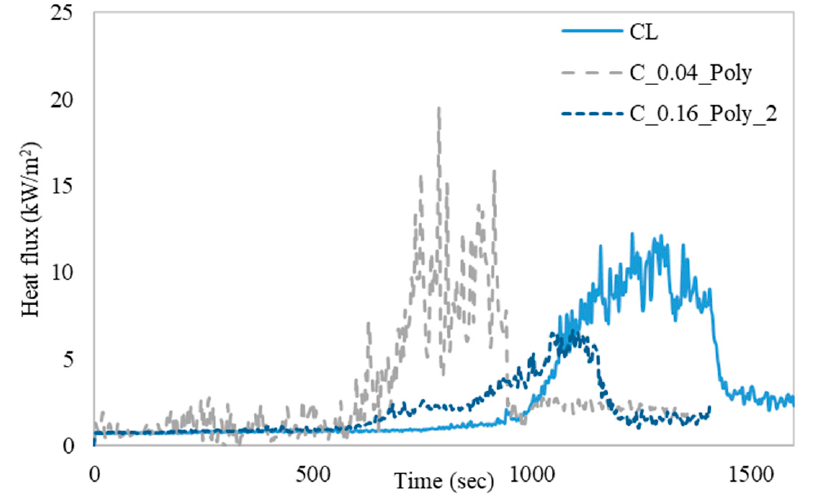
Figure 12. Heat flux at 30 cm from the door for cases: CL, C_0.04_Poly, and C_0.16_Poly_2. The potential for ignition of materials in the vicinity of a burning dwelling will be determined largely by three aspects of heat flux: magnitude, duration, and variability.